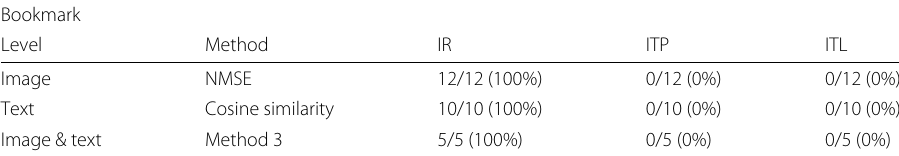
Table 9 Error distribution of